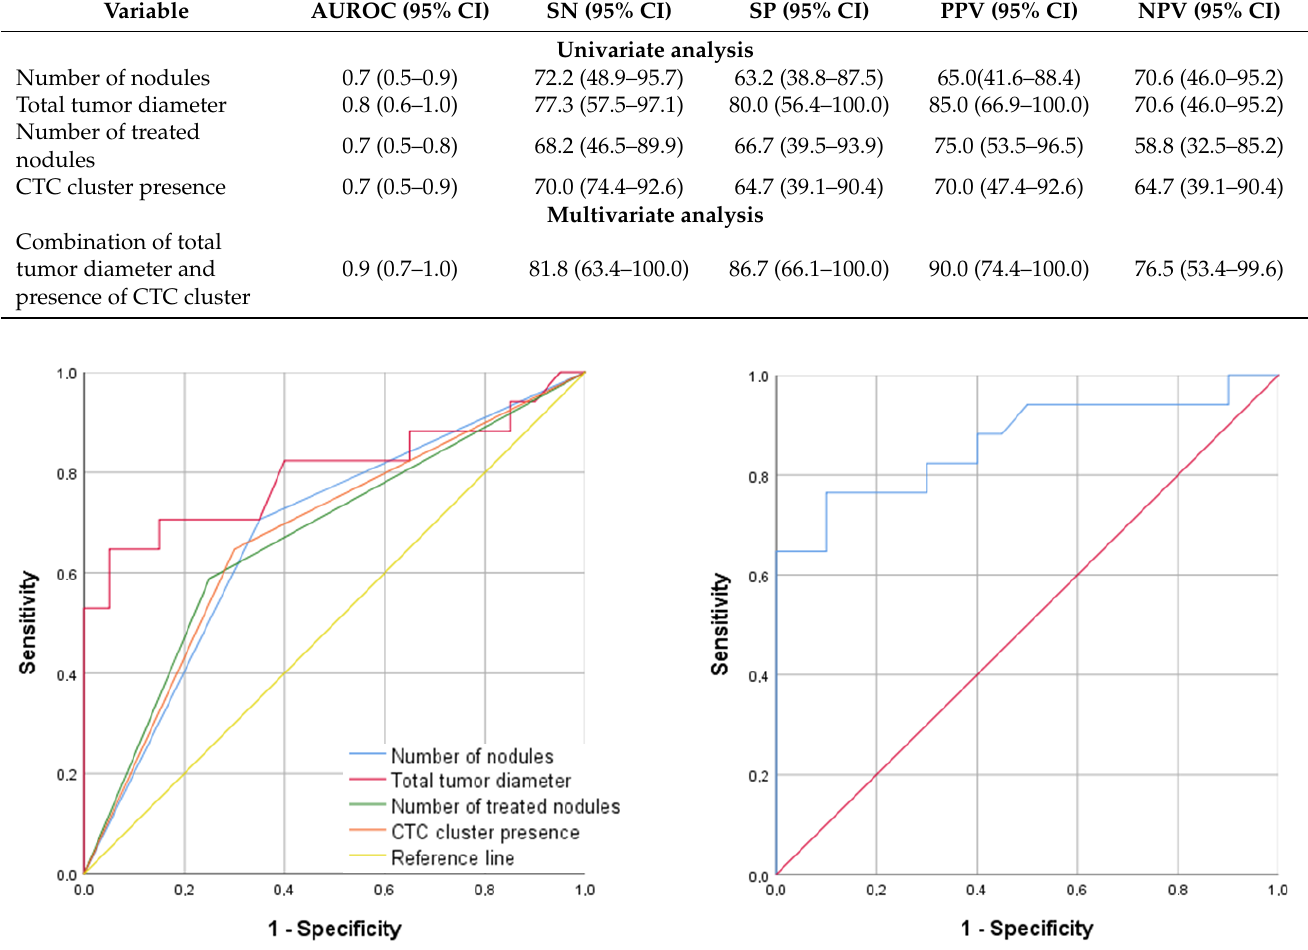
Figure 1. ROC curve showing the best diagnostic ability to predict patient response to TACE. ( Left panel): individual ROC curves for the following predictors: multinodular disease, total tumor diameter, number of treated tumor nodules, and the presence of CTC clusters. ( Right panel): ROC curve for the combination of total tumor diameter and CTC clusters at baseline by logistic regression. The median follow-up after TACE was 12.0 months (IQR 6.0–20.0). Patients who underwent liver transplantation during follow-up (n = 11, 29.7%) were censored in the survival analysis. There were twelve deaths (32.4%), eight of them (21.6%) were related with tumor progression. Neither the CTC count nor the presence of CTC clusters were associated with transplant-free survival rates ( p = 0.881 and p = 0.796, respectively; Figure 2 and Table 5). Table 5. Data for overall survival-rates at 6, 14, and 24 months after TACE therapy. Overall